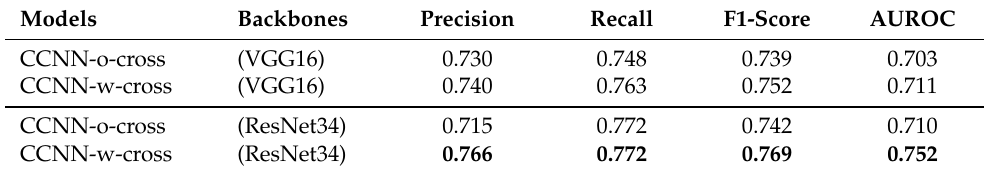
Table 5. Ablation study of with/without triple stream on cross-modality dataset TNO.